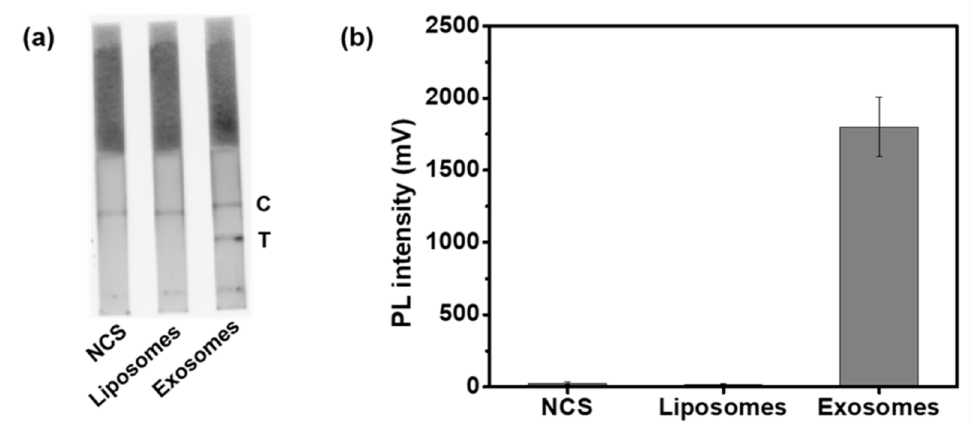
Figure 4. Characterization of the M–QD–SNs test strip system specificity. ( a ) Fluorescence image and corresponding ( b ) quantification of test strips with 33 µ L of sample. Strips contained exosomes (at a concentration of 1000 exosomes/ µ L), standard liposomes (negative control), or newborn calf serum (NCS, blank